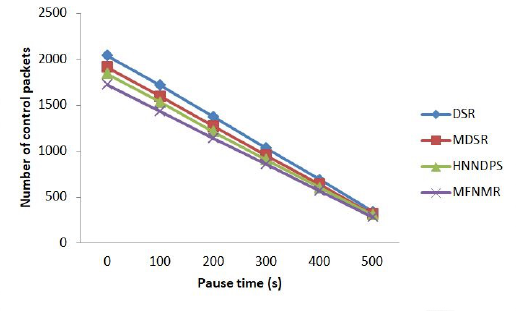
Figure 18. Routing Overhead Analysis based on Pause